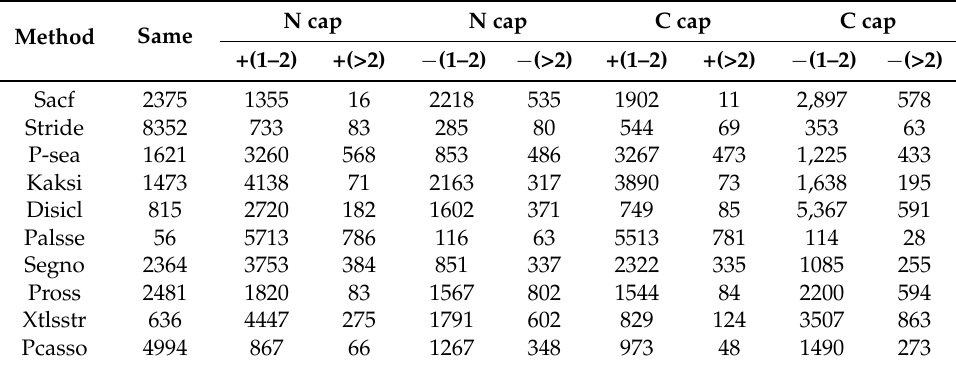
Table 5. Discrepancies between N and C caps in the β -sheets assigned by DSSP and other